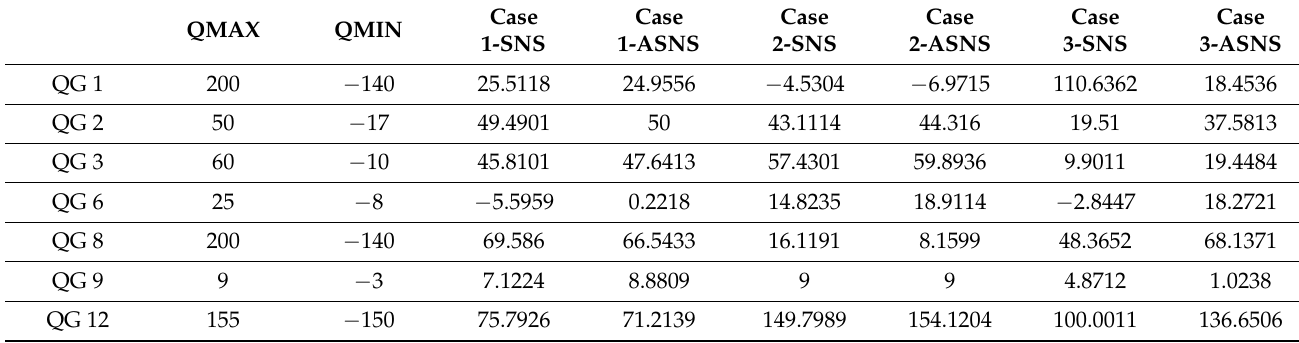
Table A3. Generators’ reactive power for the IEEE 57-bus